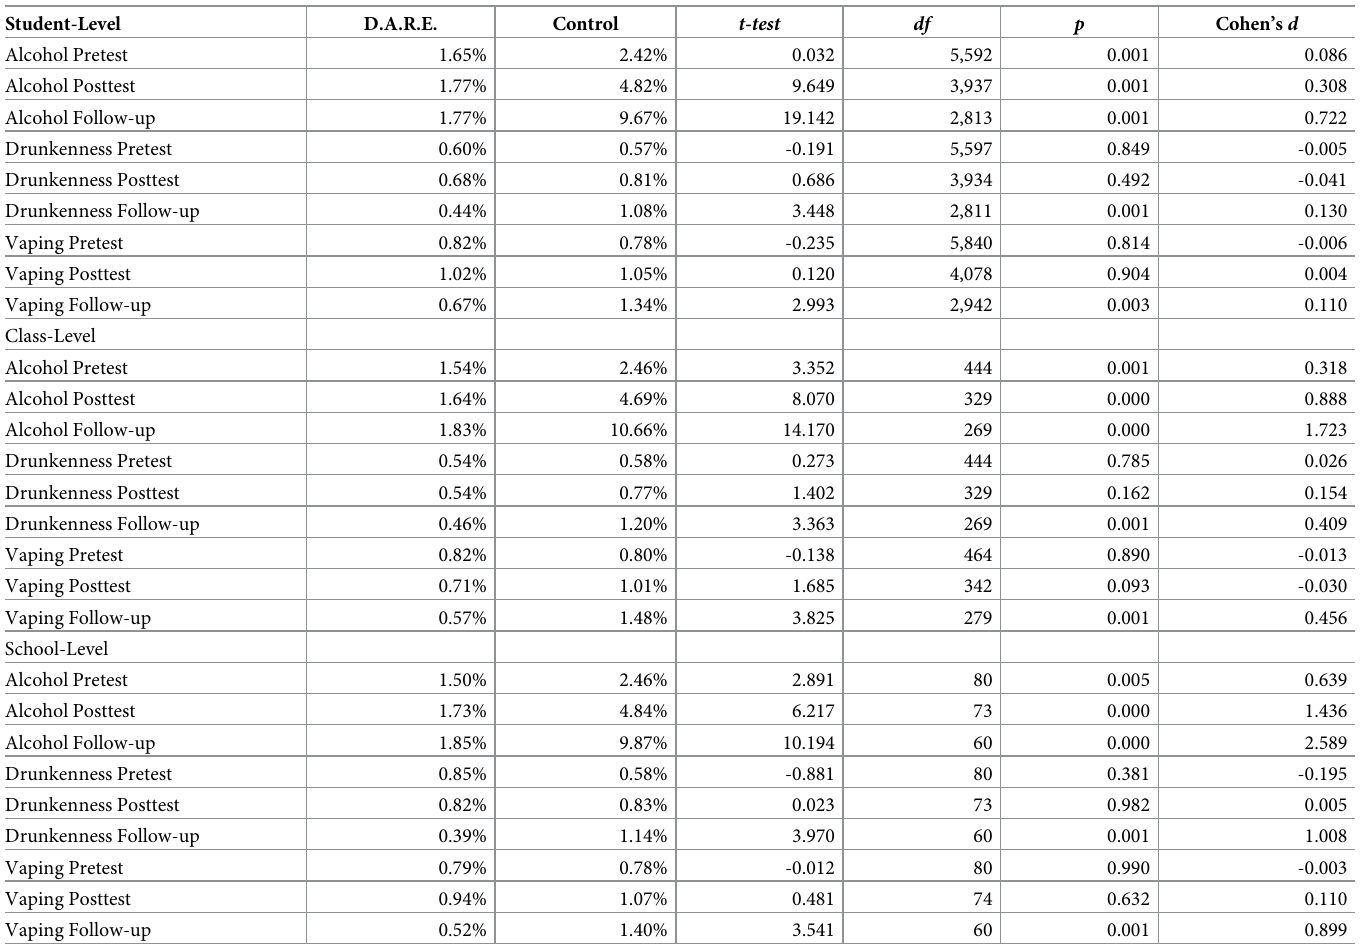
Table 3. D.A.R.E. versus virtual control behavioral outcomes for pretest, posttest, and